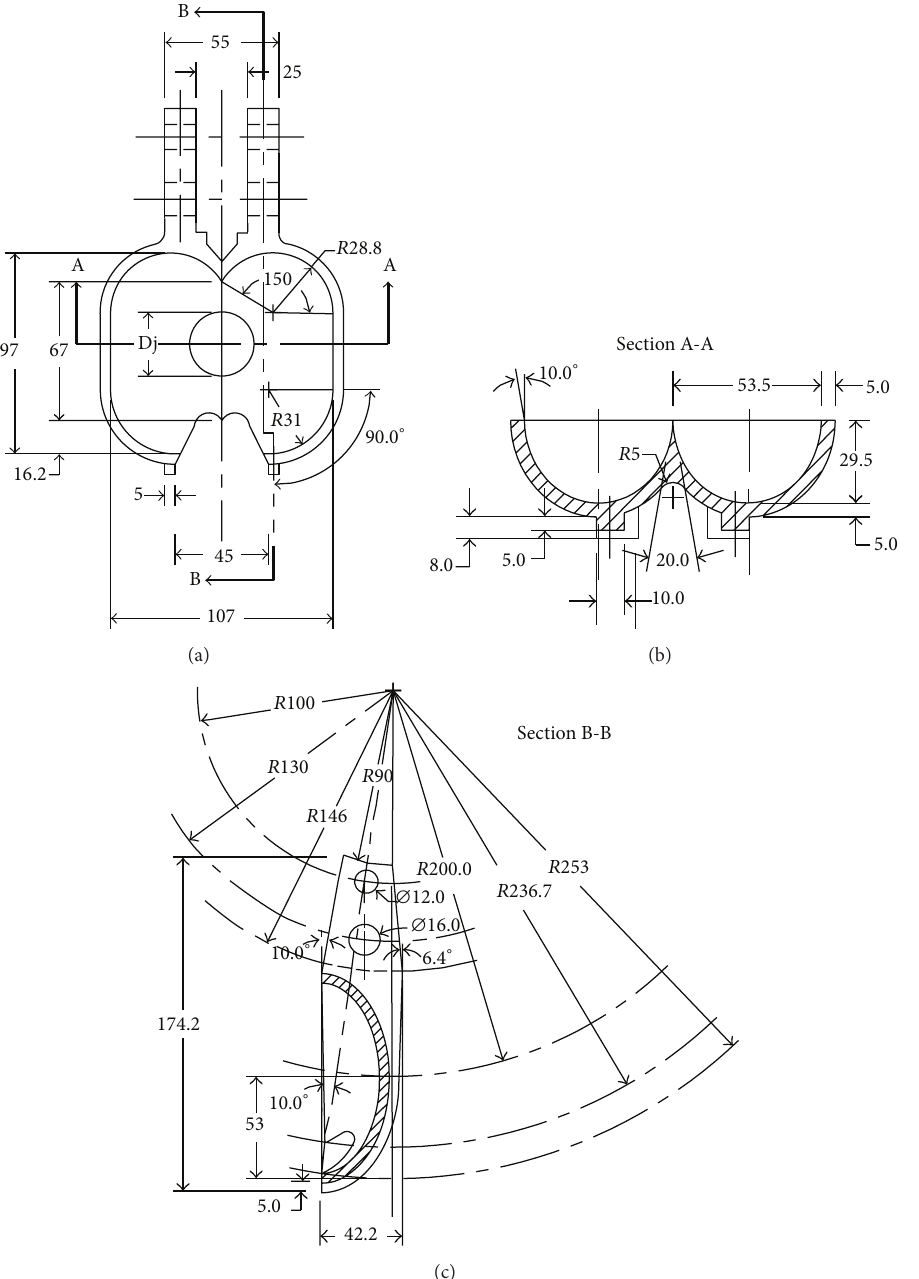
Figure 4: Details of the runner design